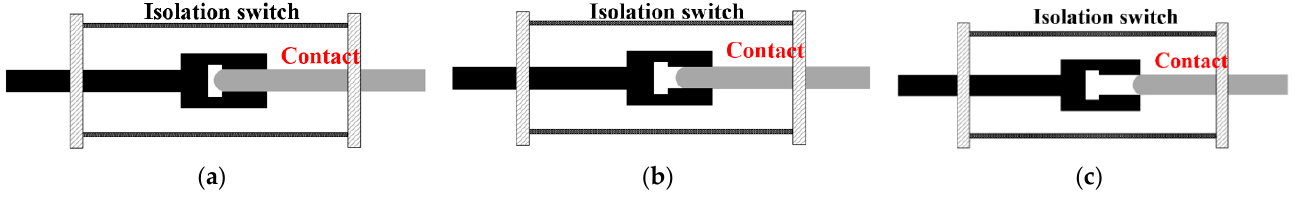
Figure 9. Mechanical defects setup. ( a ) Normal case; ( b ) mild poor contact; ( c ) serious poor contact.